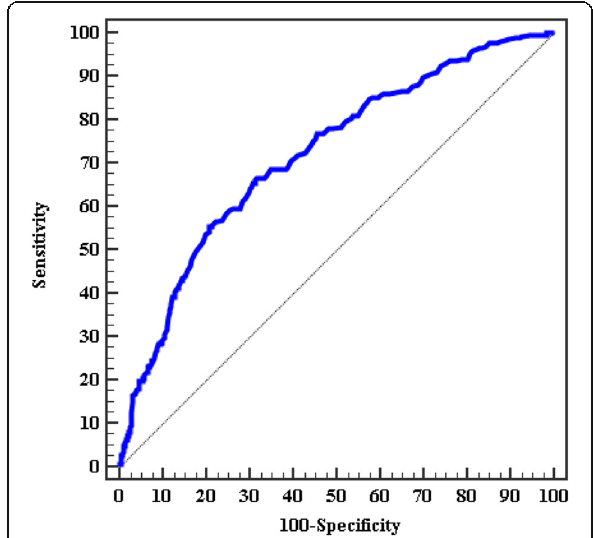
Fig. 6 66 year male with history of coronary heart disease referred for myocardial viability. a Late gadolinium enhancement (LGE) was found sub-endocardial enhancement of the anterior and inferolateral segments (arrows). b Non-contrast-enhanced T1 mapping shows that high native T1 value of the corresponding regions including LGE (1100 ms)